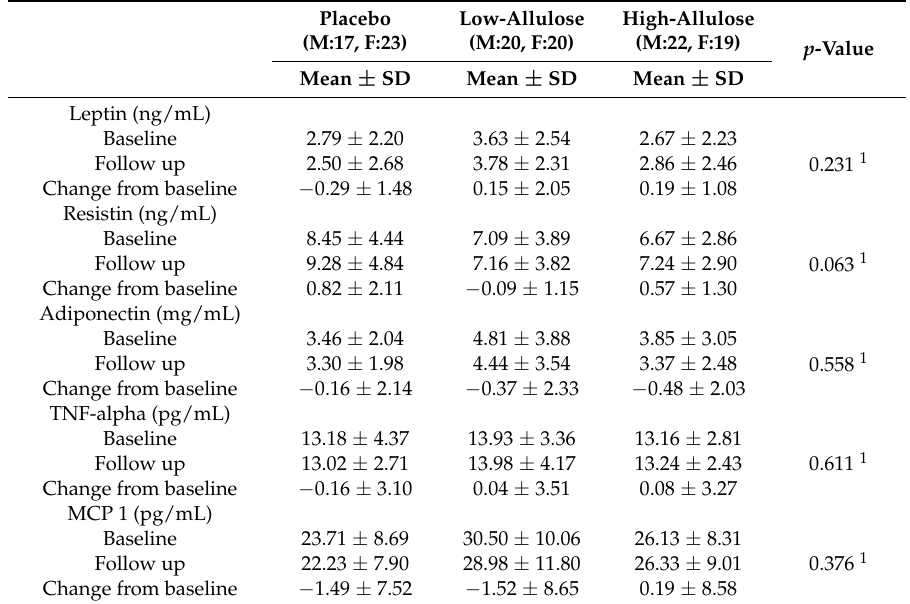
Table 8. Dose-dependent effect of supplementation of D -allulose for 12 weeks on plasma adipokine levels in overweight or obese subjects.